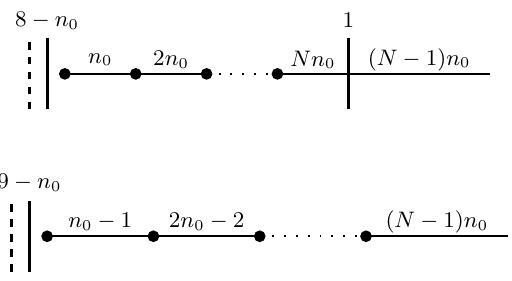
Figure 13. Top: activating one Jordan block of size N means letting N (out of Nn 0 ) D6’s end on a single D8. Bottom: we can then rearrange the brane system via simple Hanany-Witten